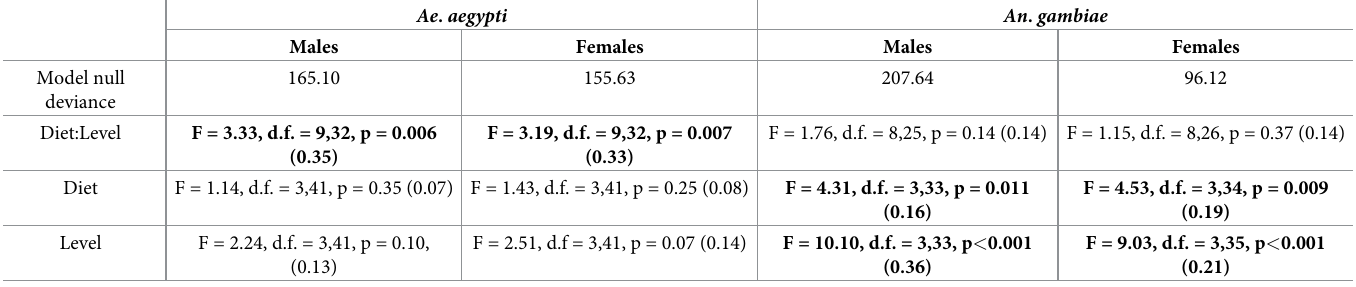
Table 3. Model summary statistics estimating the influence of diet type and level on the number of male and female pupae eclosing to adults with the effect size (proportion of the deviance explained) indicated in parentheses (significant effects in bold). Ae .